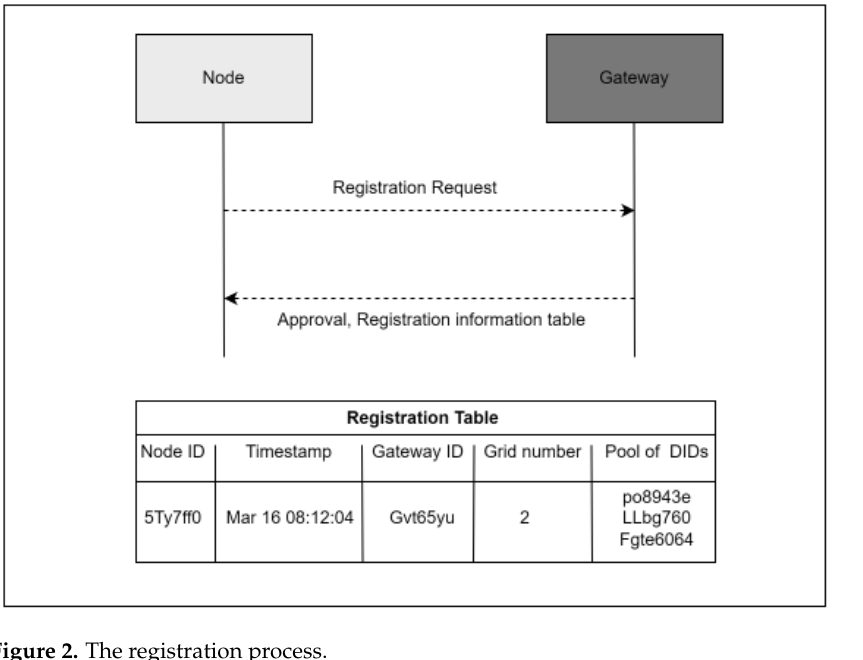
Figure 2. The registration process.